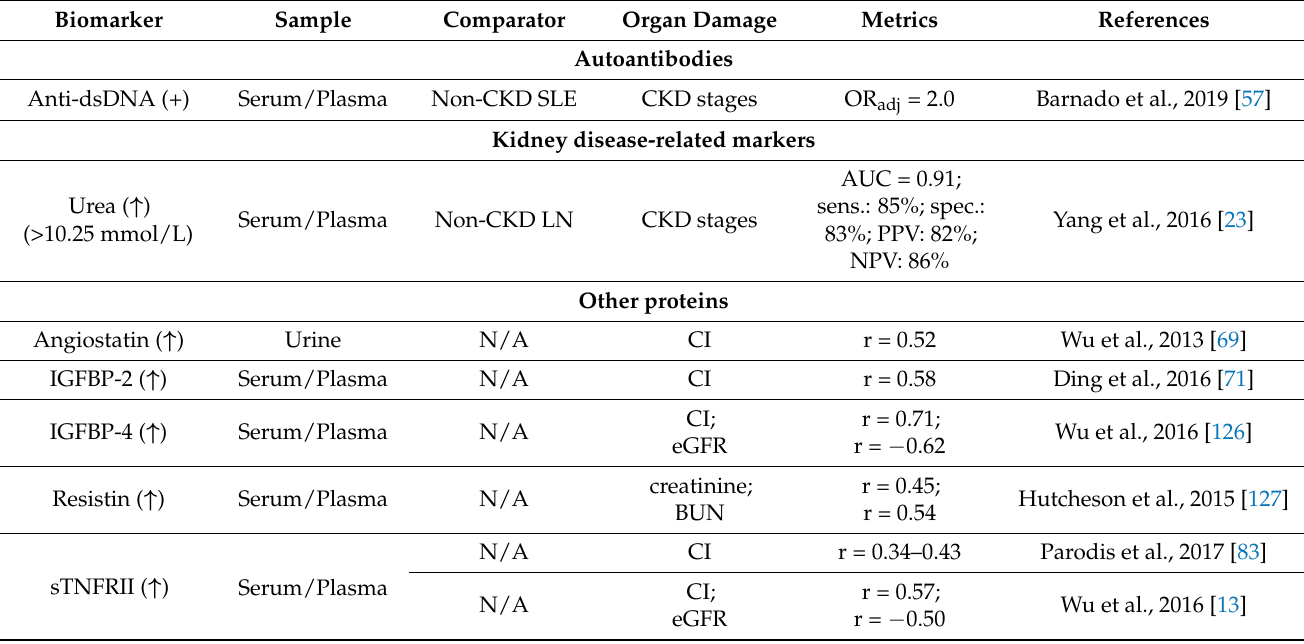
Table 4. Performances of selected biomarkers of organ damage in